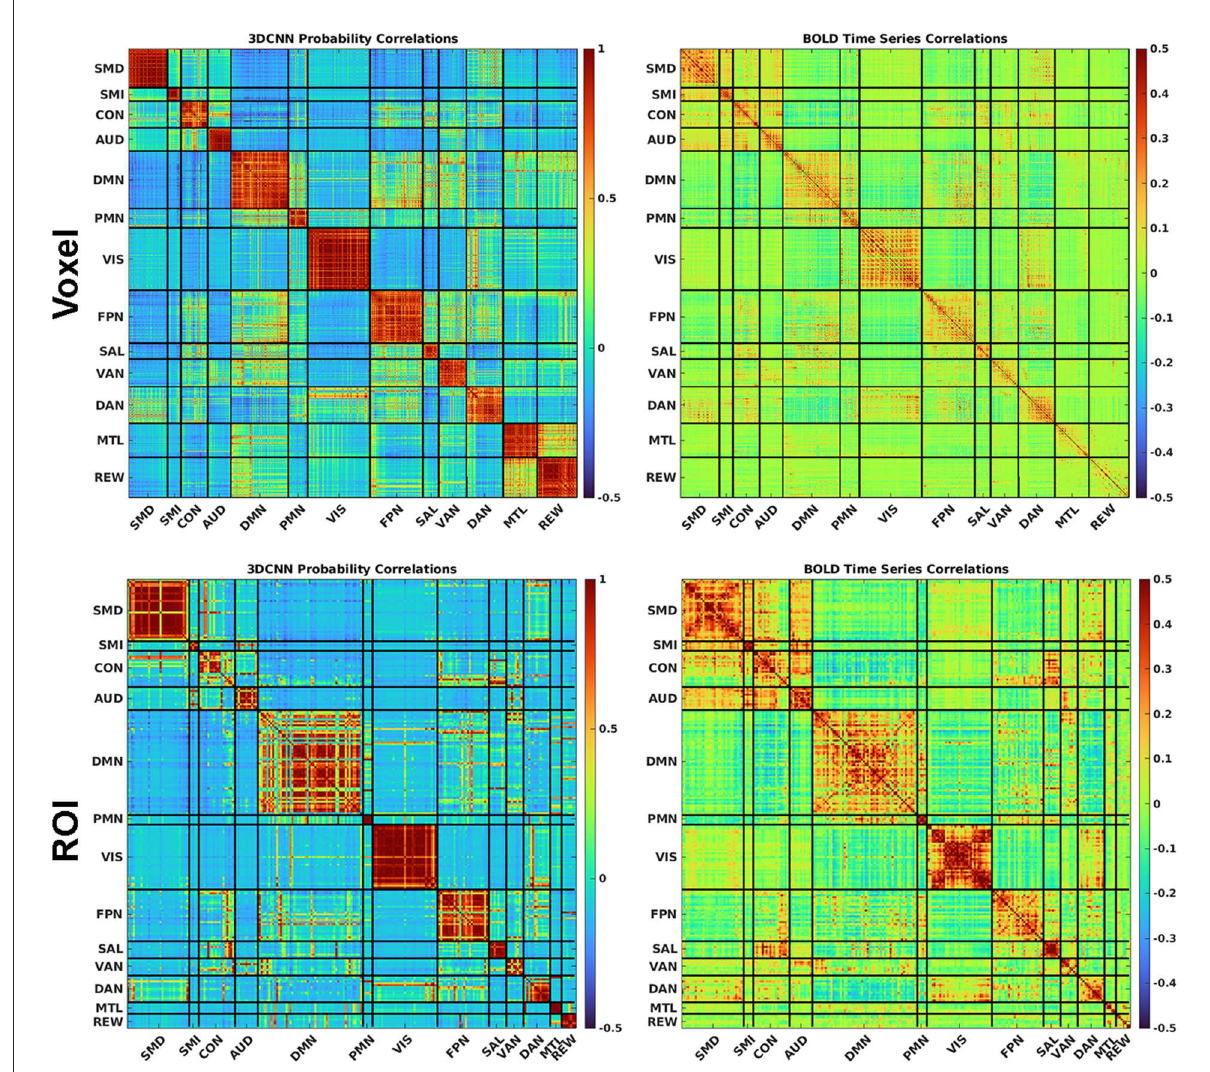
FIGURE8 The 3DCNN allows for novel similarity measures. Softmax marginal probabilities can be correlated to generate alternative connectivity matrices between functional regions. Correlations between 3DCNN softmax probabilities are compared to correlations between BOLD time series for voxels (top row) and ROIs (bottom row) . The 3DCNN shows higher correlations and greater contrast between regions compared to conventional BOLD correlations. SMD, dorsal somatomotor; SML, lateral somatomotor; CON, cinguloopercular; AUD, auditory; DMN, default mode; PMN, parietal memory; VIS, visual; FPN, frontoparietal; SAL, salience; VAN, ventral attention; DAN, dorsal attention; MTL, medial temporal; and REW, reward.